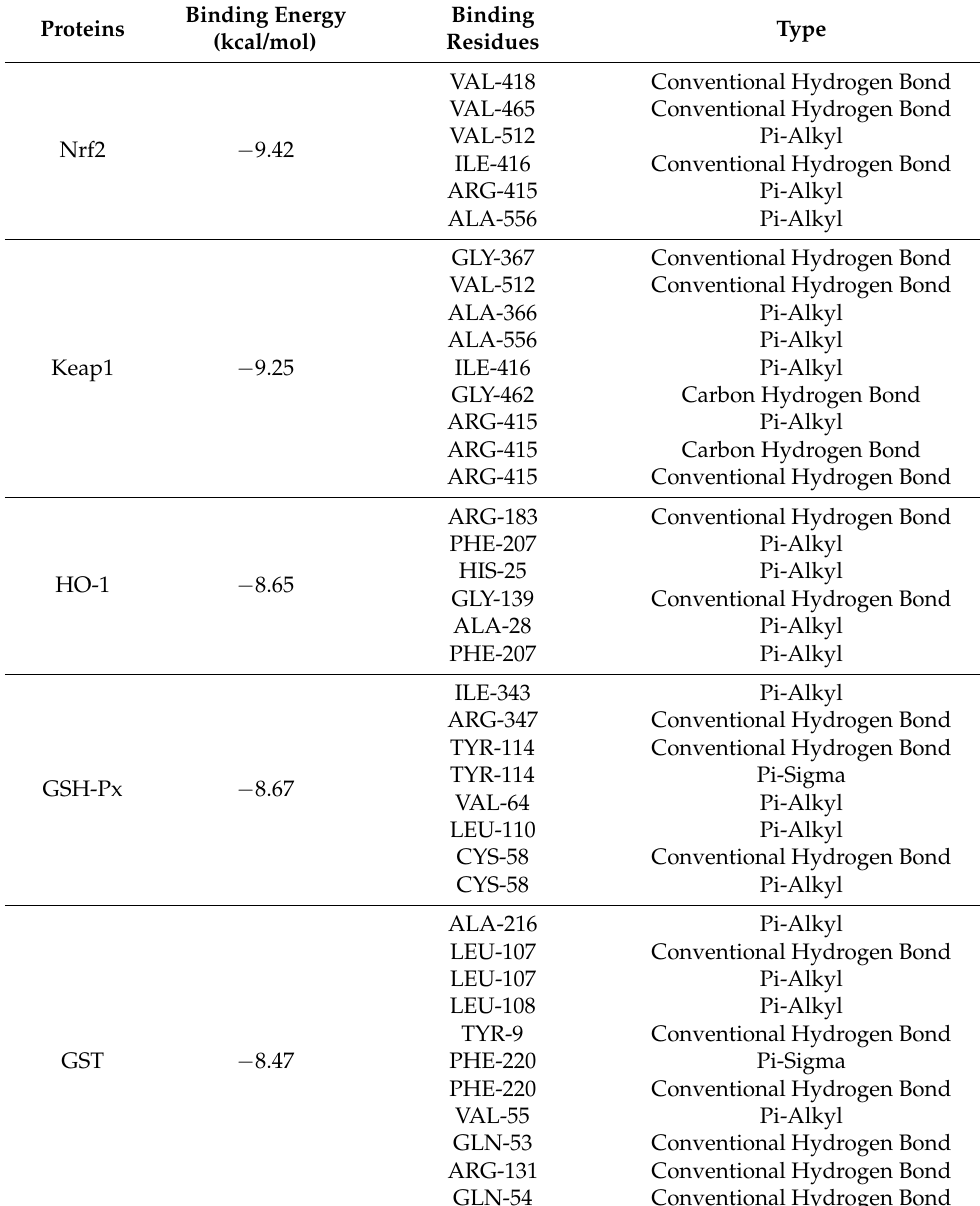
Table 5. Intermolecular interactions between obeticholic acid and Nrf2, Keap1, HO-1, GSH-Px, and